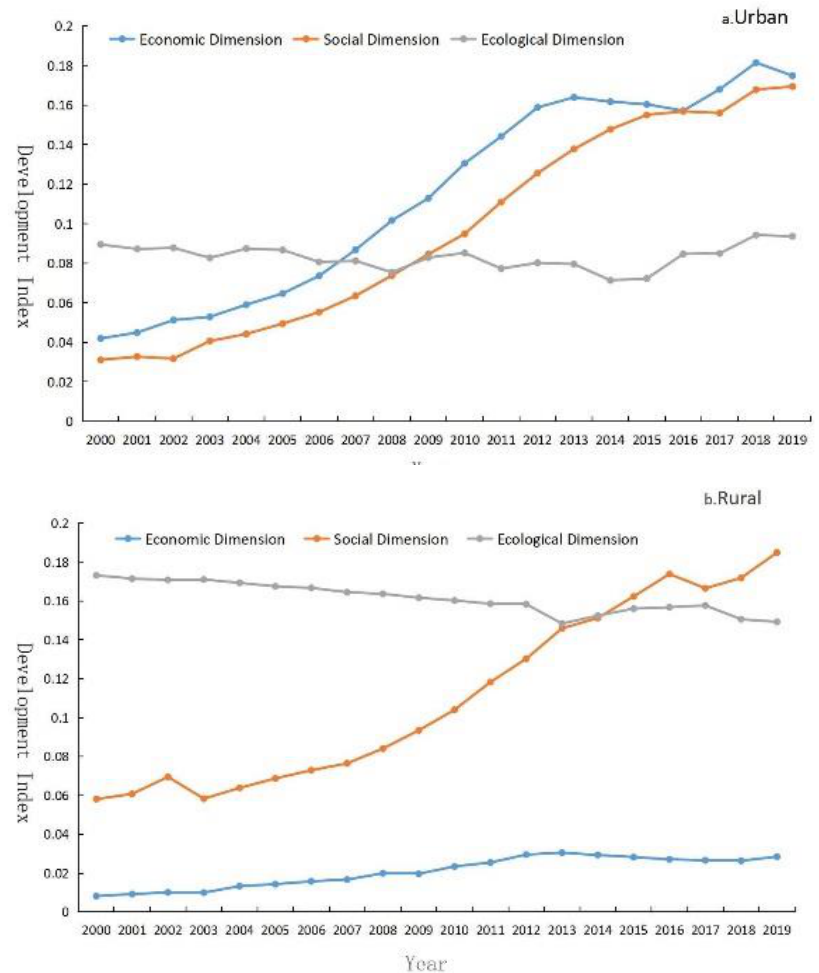
Figure 4. Changes in Various Dimensions of Development Levels of Urban and Rural Areas in the Three Northeastern Provinces. ( a ) Urban; ( b ) Rural.